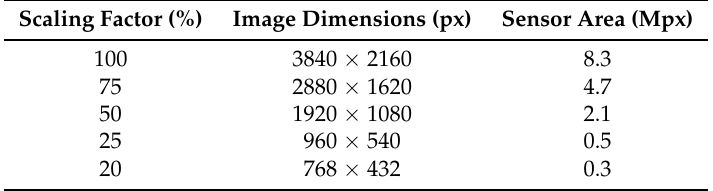
Table 3. Rescaled sensor